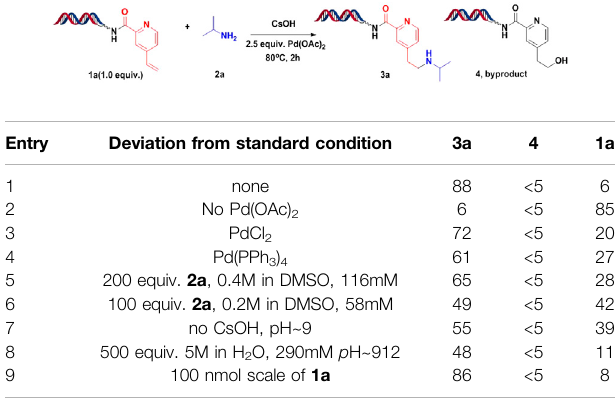
TABLE 1 | Condition optimizations of C-N bond